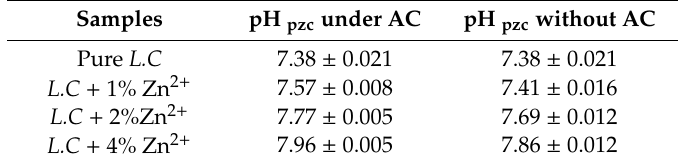
Table 2. pH pzc of hybrid material synthesized in absence and presence of